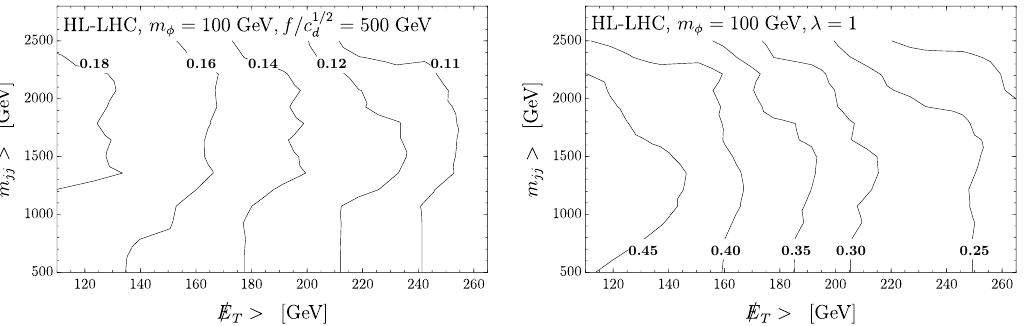
) cuts, at the , m T jj